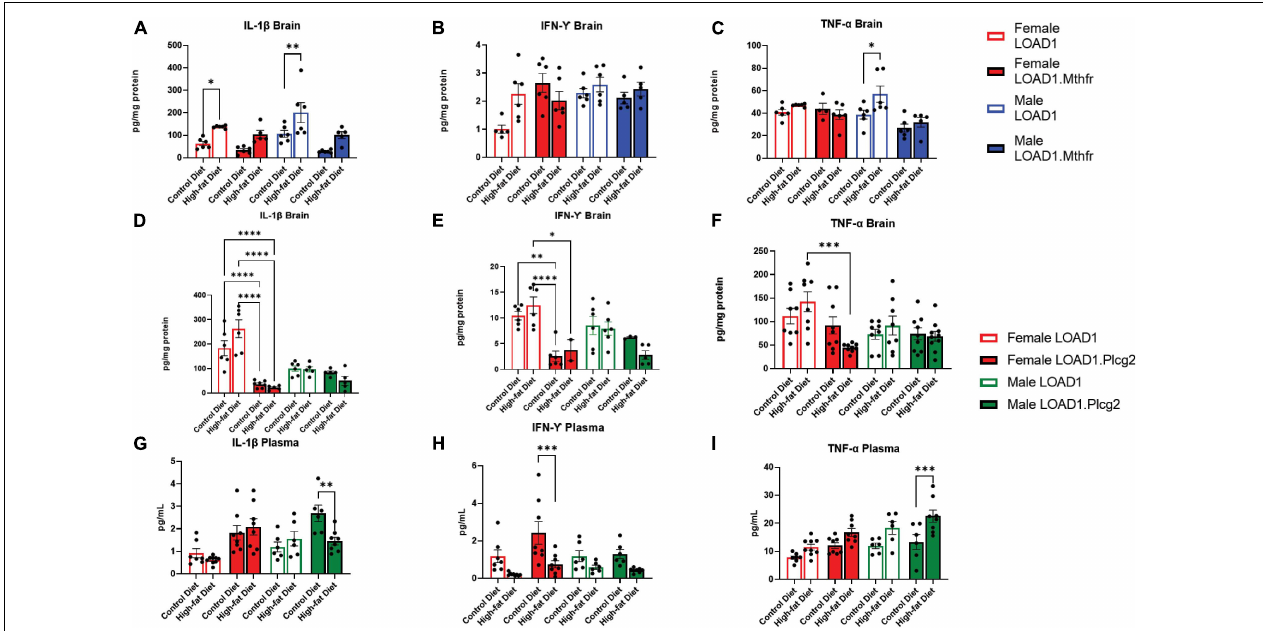
FIGURE 4 | Cytokine production is altered in mice fed with HFD. In order to identify peripheral factors that may be driving the genetic by diet interaction, we examined the brain (A–F) and plasma (G–I) cytokines in both LOAD1. Plcg2 M 28 L or LOAD1. Mthfr 677 C > T mice. In LOAD1 mice, significant increases in brain IL-1 β (A) and TNF-a (C) were observed in mice fed with HFD; however, LOAD1. Mthfr 677 C > T mice did not have any significant increases. In the LOAD1. Plcg2 M 28 L mice, a significant decrease in brain IL-1b (D) and IFN-g (E) was observed in the females, regardless of diet. The HFD did not show the same increase in the brain cytokine levels as the control (LOAD1) animals, suggesting a deficiency in cytokines due to the variant. TNF-a was reduced in females as well (F) , but only in the HFD group. In the plasma of LOAD1. Plcg2 M 28 L mice, we observed a reduction in IL-1b (G) and IFN-g (H) in male and female, respectively, LOAD1. Plcg2 M 28 L mice. The TNF-a was elevated in the HFD LOAD1. Plcg2 M 28 L males only (I) . Statistical analysis was completed using an ANOVA followed by Tukey’s post hoc tests. P < 0.05 is considered